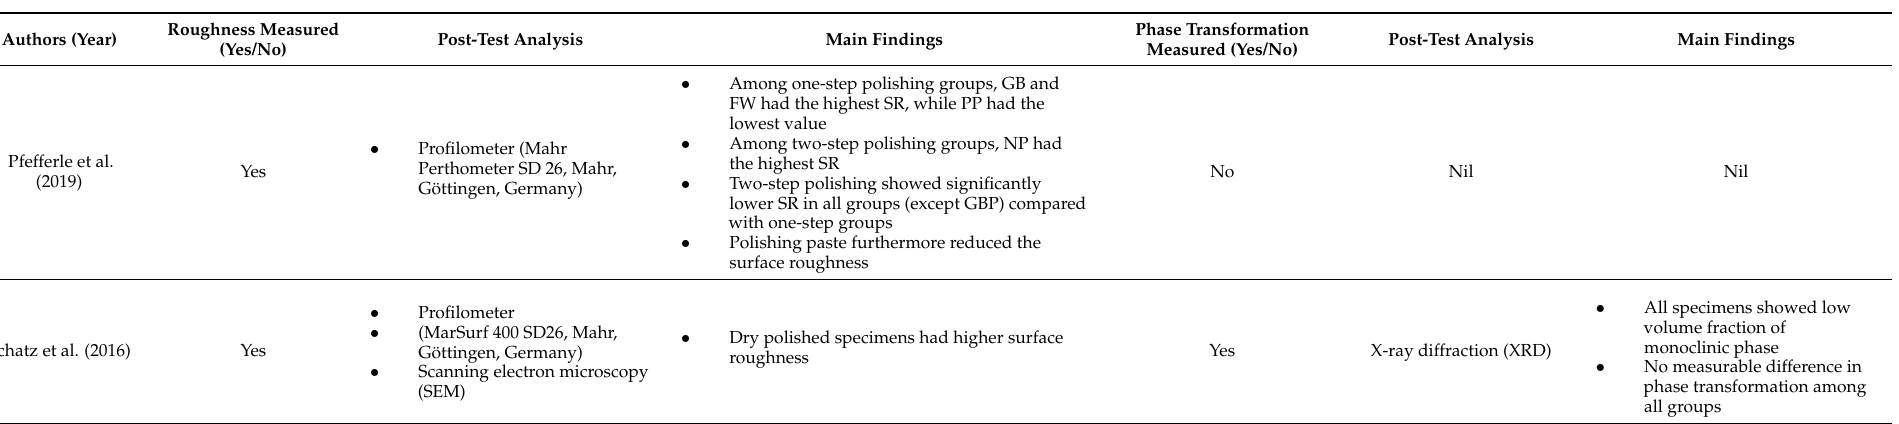
Table 4. Summary of measurements in surface roughness and phase transformation of included